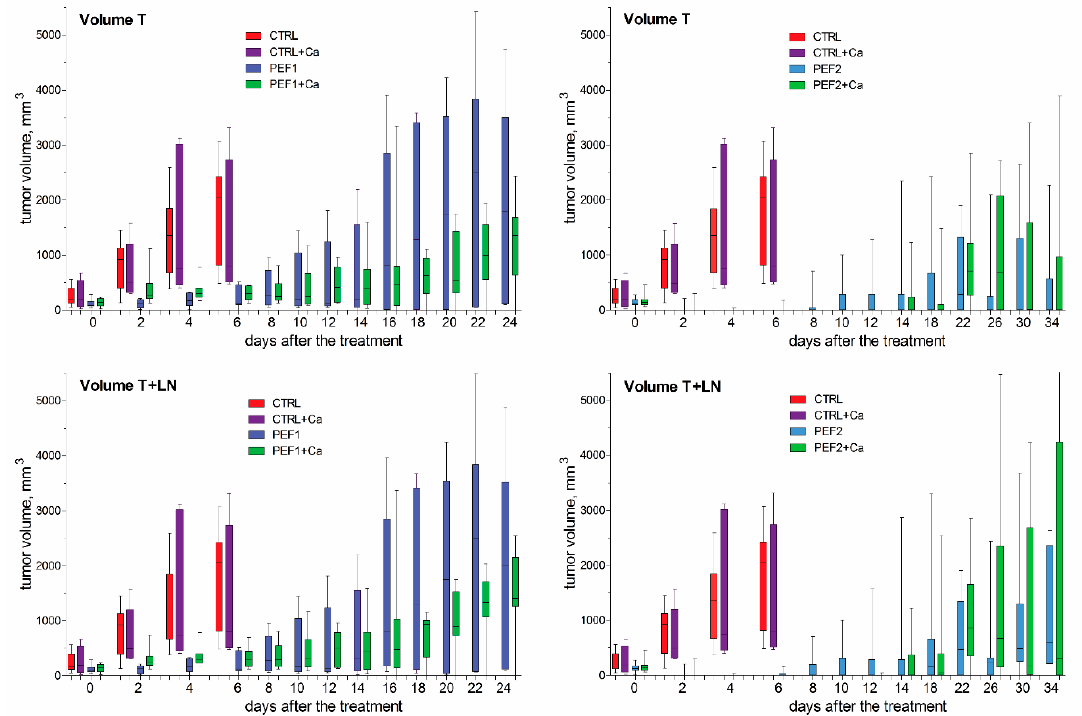
Figure 3. Volumetric changes of the tumors after pulsed electric fields (PEF) and calcium electroporation (PEF + Ca) treatment. Volumes of the primary tumor (Volume T) and the sum of the volumes of primary tumor + secondary tumors in lymph nodes (Volume T + LN) are shown. CTRL—tumor bearing control mice without treatment; CTRL + Ca—tumor bearing mice treated with CaCl 2 ; PEF1 and PEF2—tumor bearing mice treated with PEF1 protocol: 12 kV / cm × 200 ns × 500 (0.006 J / pulse) or PEF2 protocol—12 kV / cm × 500 ns × 500. PEF1 + Ca and PEF2 + Ca—tumor-bearing mice treated with PEF and CaCl 2 . Primary tumors in CTRL and CTRL + Ca cases developed rapidly, thus the influence of metastases in LN is